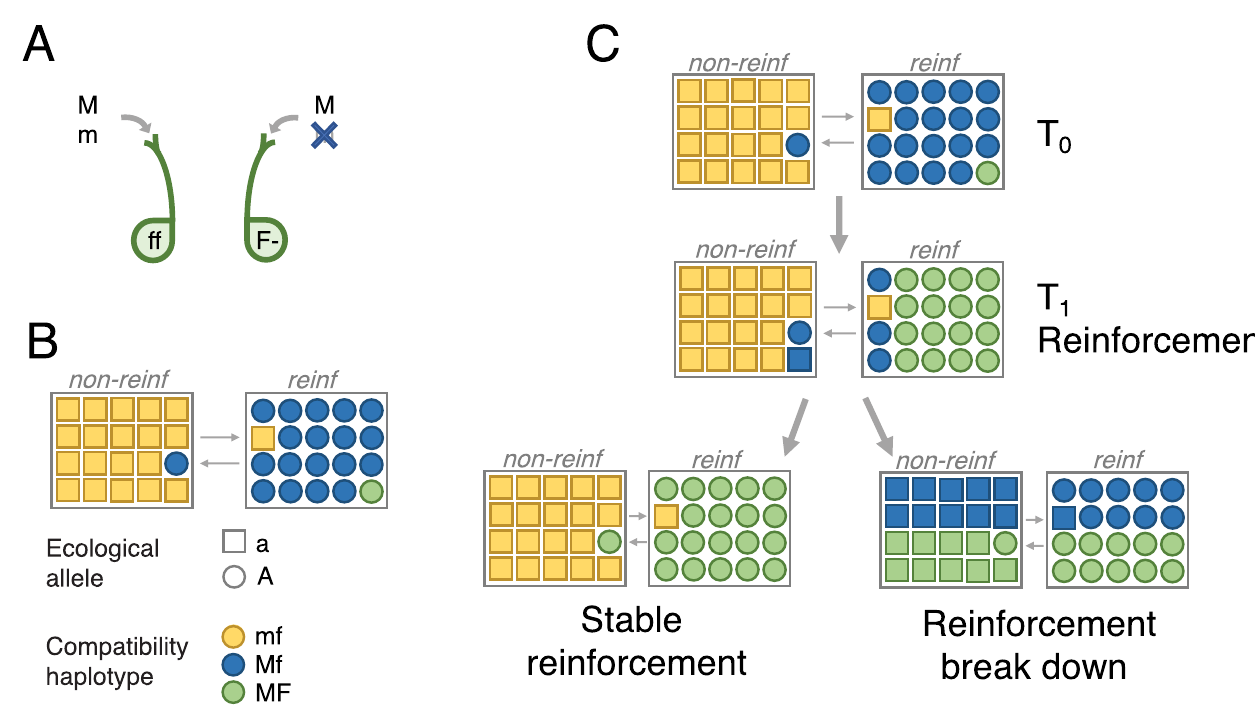
Fig 1. Model dynamics. (A) PMPZ incompatibility based on gametophytic factors. The dominant F allele at the female-expressed locus F encodes a fertilization barrier that can only be overcome by the male-expressed compatibility allele M at locus M . (B) Male gametes disperse between two populations: one reinforcing ( reinf ) and one non-reinforcing ( non-reinf ), each of which face different selective pressures. Colors denote compatibility haplotypes ( mf , Mf , MF ), and shapes signify genotypes at the A locus, which underlies divergent ecological adaptation ( a and A ). Initially, non-reinf is fixed for the compatible f female-expressed allele, the incompatible sperm/pollen-expressed m allele, and a locally adaptive allele (haplotype mfa ). reinf is initially fixed for the sperm/ pollen compatibility allele M , and locally adapted allele A , with the female-expressed incompatibility F at an initially low frequency; i.e., haplotype MfA is initially common, and MFA is initially rare in reinf . (C) We run the model from the initial generation T 0 until the F allele reaches its equilibrium. If some reinforcement evolves by time T 1 (equivalent to the F allele increasing in frequency in reinf ), two further outcomes are possible: The M allele may introgress onto the locally adaptive background and fix in both populations, leading to the breakdown of reinforcement (bottom right panel of C ); or, the M allele may fail to spread in non-reinf while F continues to spread through reinf , completing reinforcement (bottom left panel of C